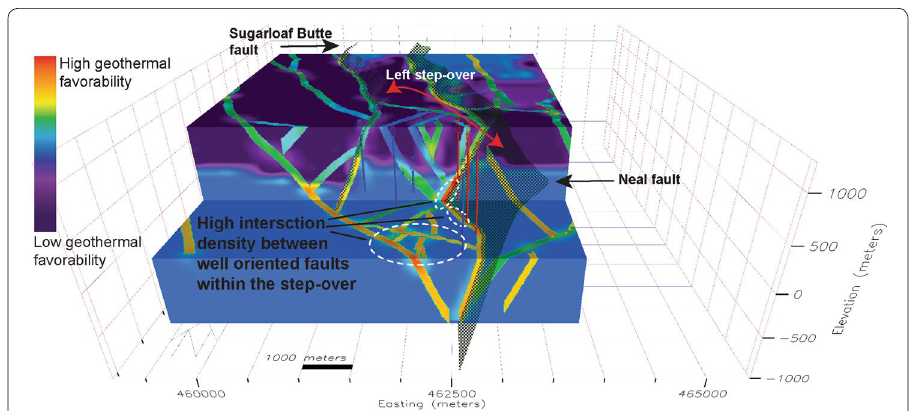
Fig. 14 3D geothermal potential map of Neal Hot Springs. Warm colors represent high potential are are associated with favorably oriented fault segments, high fault intersection/fault termination density, and the Columbia River Group volcanic section. The white-dashed outlined area of high geothermal potential is interpreted as the most likely location for geothermal fluid upwelling associated with geothermal production at Neal